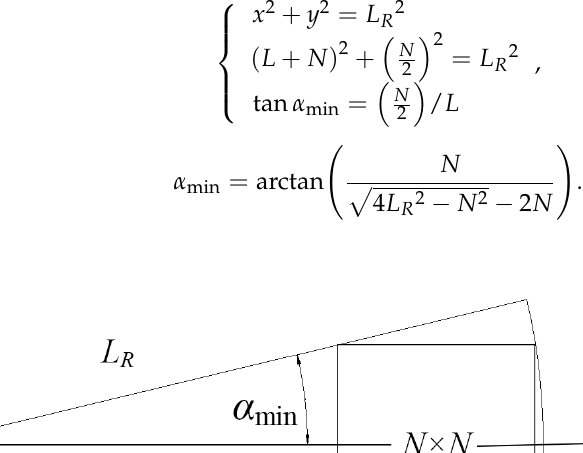
Figure 6. Sector searching area with a minimum central angle.